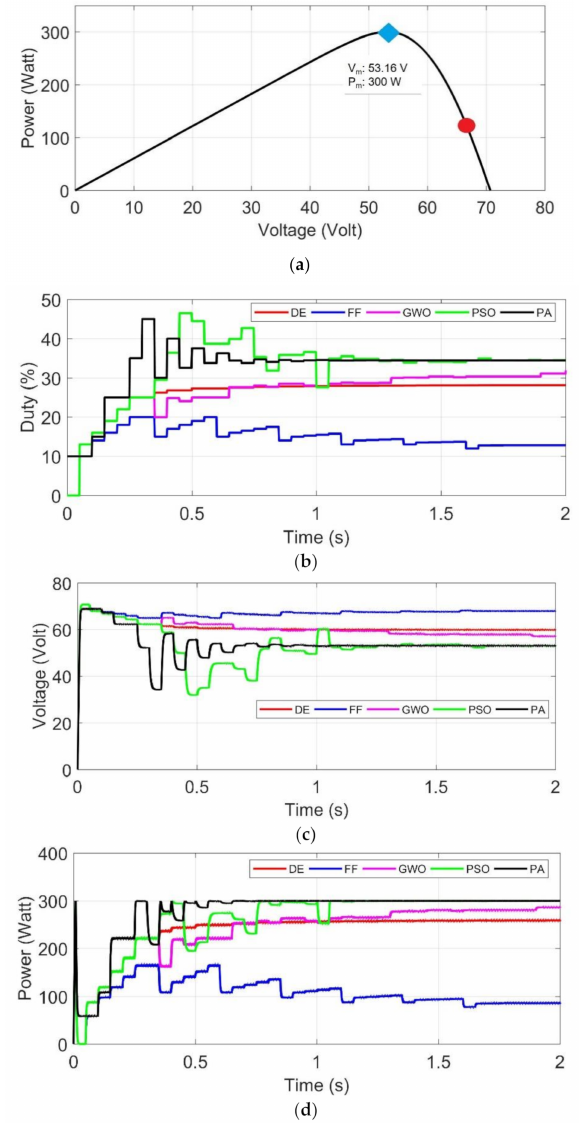
Figure 10. Test 2 ( a ) Initial particles ( b ) Duty cycle (%) ( c ) PV voltage (V) ( d ) PV power